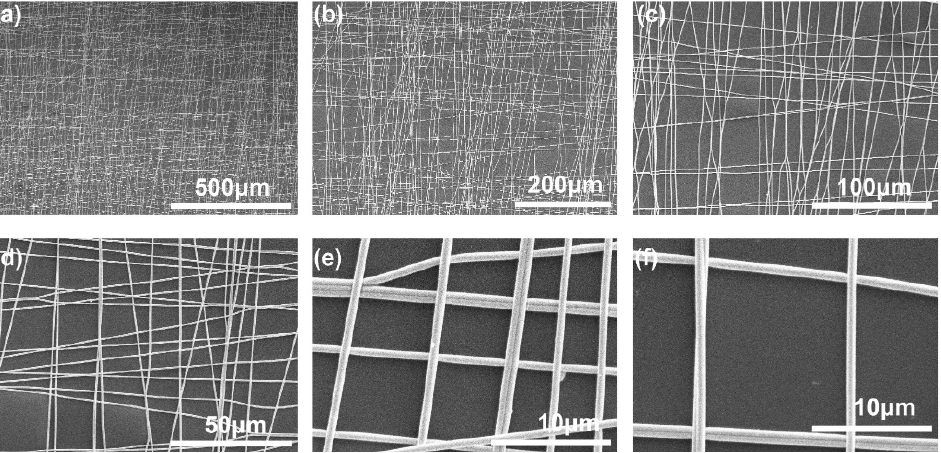
Figure 2. SEM images of the bidirectional Ag-PVA nanofibers, revealing a uniform nanofiber membrane. ( a – d ) The SEM images under different magnification to show the uniform distribution of the bidirectional NFs membrane. ( e , f ) Enlarged SEM images to demonstrate the individual NFs and their cross connections.